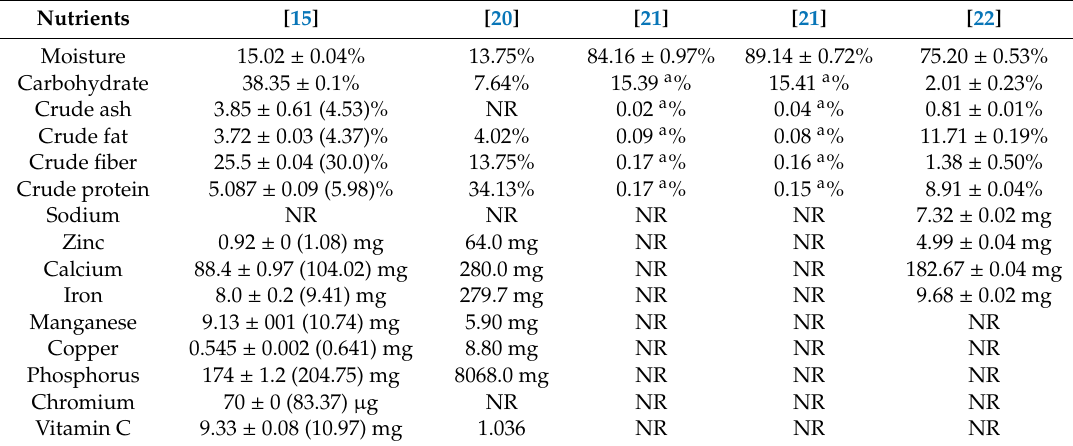
Table 1. Nutritional composition of ginger.